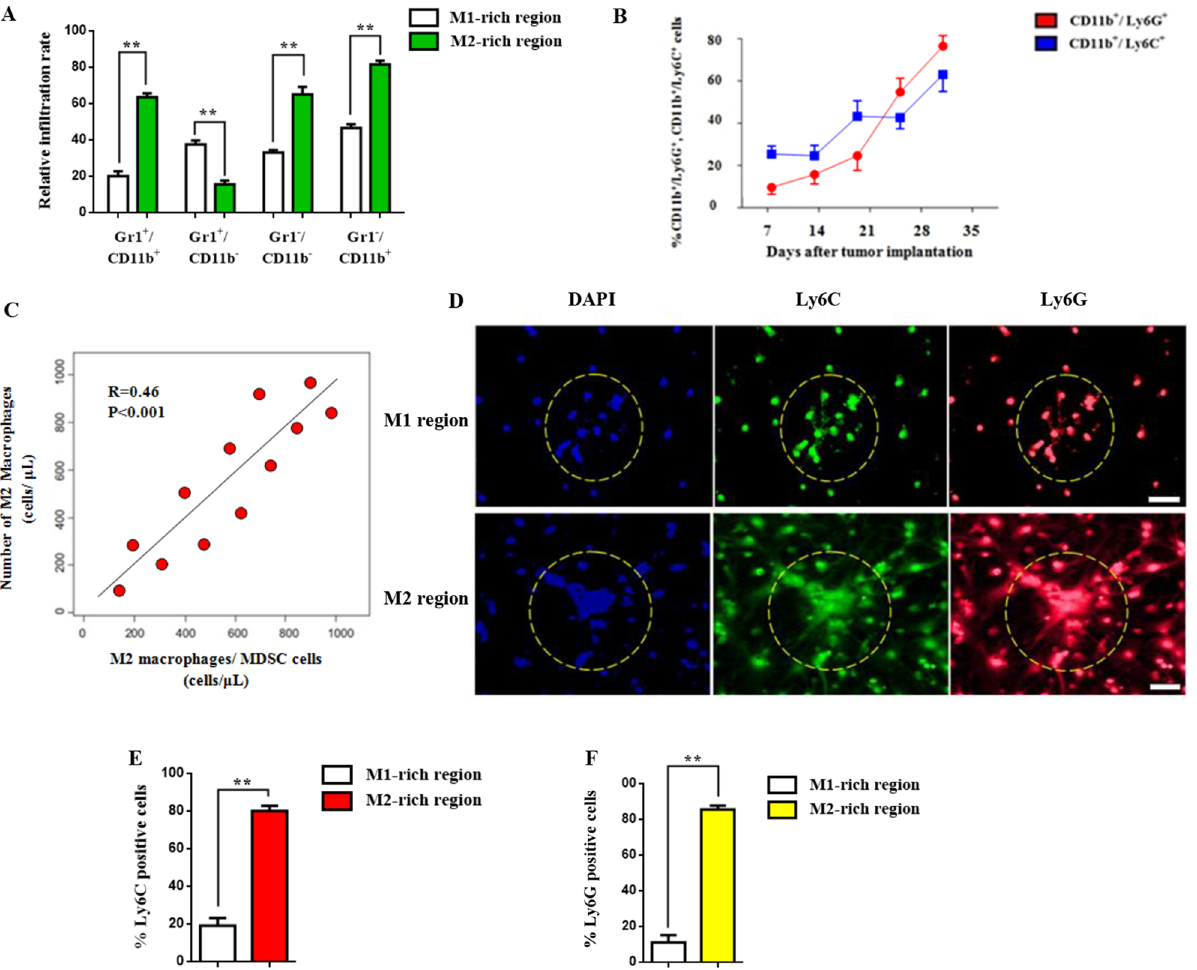
Figure 3. Monocytic MDSC subsets Gr1 − /CD11b − , Gr1 − /CD11b + elicit M2 macrophage enrichment. ( A ) Relative infiltration rate of MDSC subsets in M1/M2 macrophage regions. MDSC infiltration was evaluated by the presence of gMDSC (Gr − /CD11b − ) and mMDSC (Gr − /CD11b + ) cells in primary and metastatic tissues. ( B ) Induction and infiltration of mMDSCs (CD11bLy6C+) and gMDSCs (CD11b + Ly6G+) in, lung and lymph node tumor. A549 cells (2 × 106) were orthotopically implanted in C57BL/6 mice. Monitoring of MDSCs infiltration started three days post impantation. ( C ) Graph showing positive correlation between the M2/MDSC ratio and M2 macrophage cell numbers. ( D ) Immunofluorescence analysis of Ly6C/Ly6G positive cells in mice bearing A549 tumors (magnification × 200). Confocal microscopy images of Ly6C (green), Ly6G labeled cells (red) and DAPI (blue). Images were captured using Carl Zeiss fluorescence confocal microscope. ( E , F ) Data represent the mean ± SD of three independent experiments (*p < 0.05; **p < 0.01). Differences were considered statistically significant at p < 0.05. Statistically significant data are indicated by asterisks (*p < 0.05, **p <